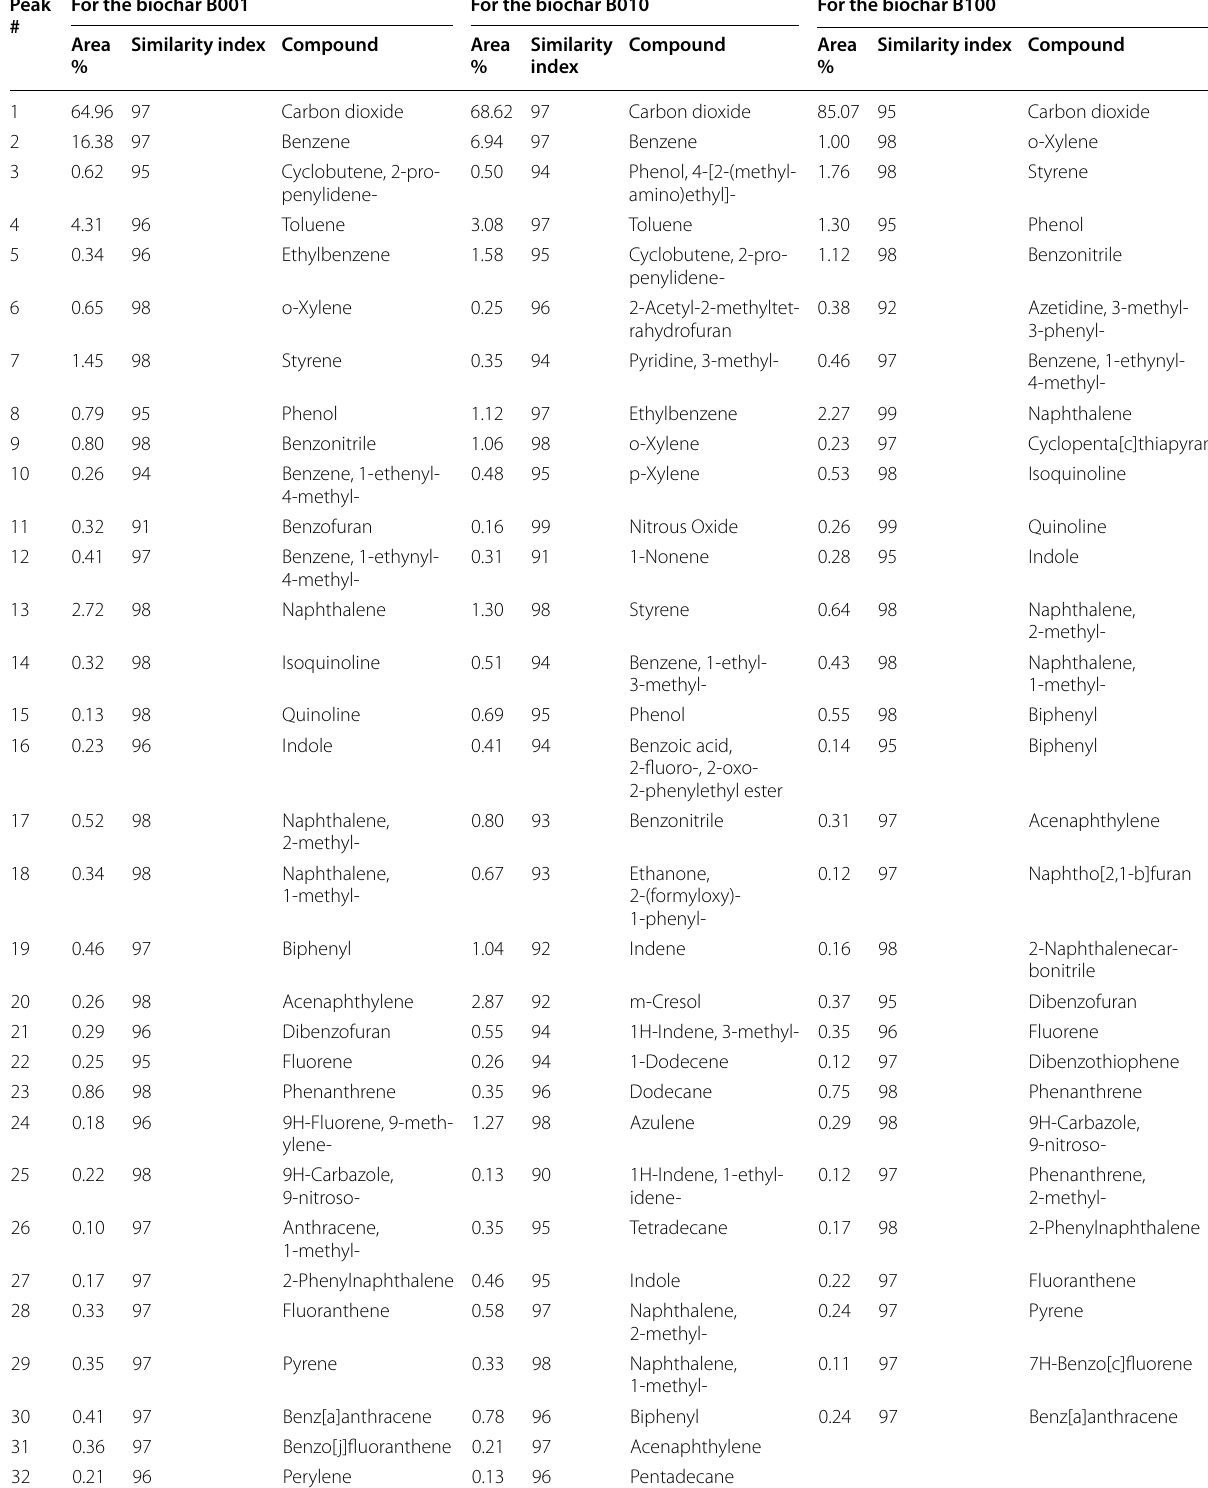
Table 4 List of identified compounds, their relative %-area, and similarity index during the analytical pyrolysis (using Py-GC–MS) of